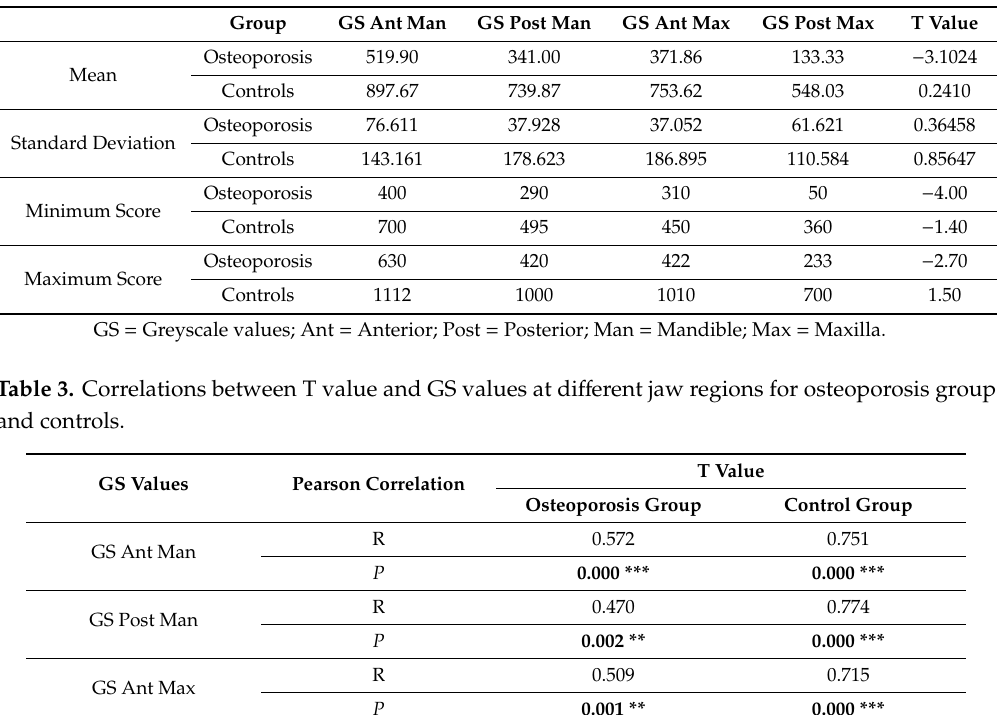
Table 2. Distribution of means, standard deviations, maximum and minimum scores of T value and GS values at di ff erent jaw regions for osteoporosis group and controls.